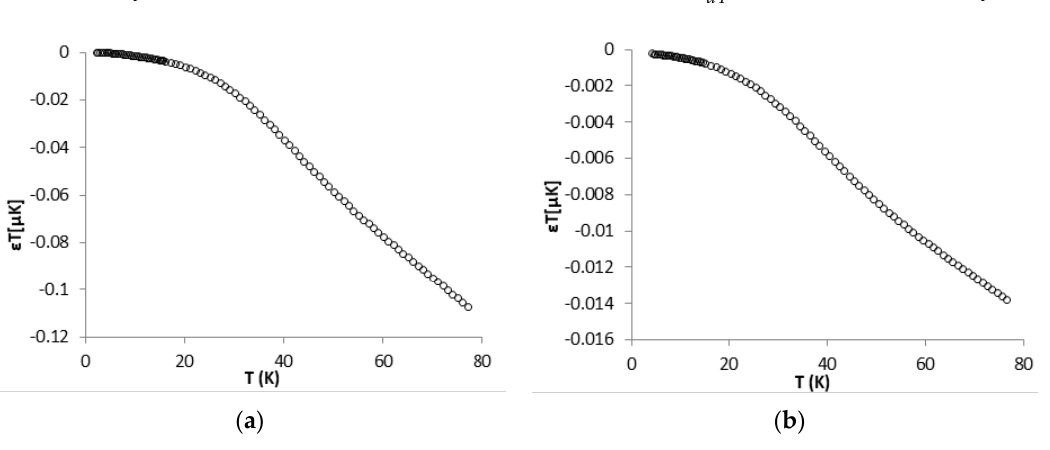
Figure 8. Absolute temperature resolution of: Sensor 1 ( a ); and Sensor 2 ( b ).